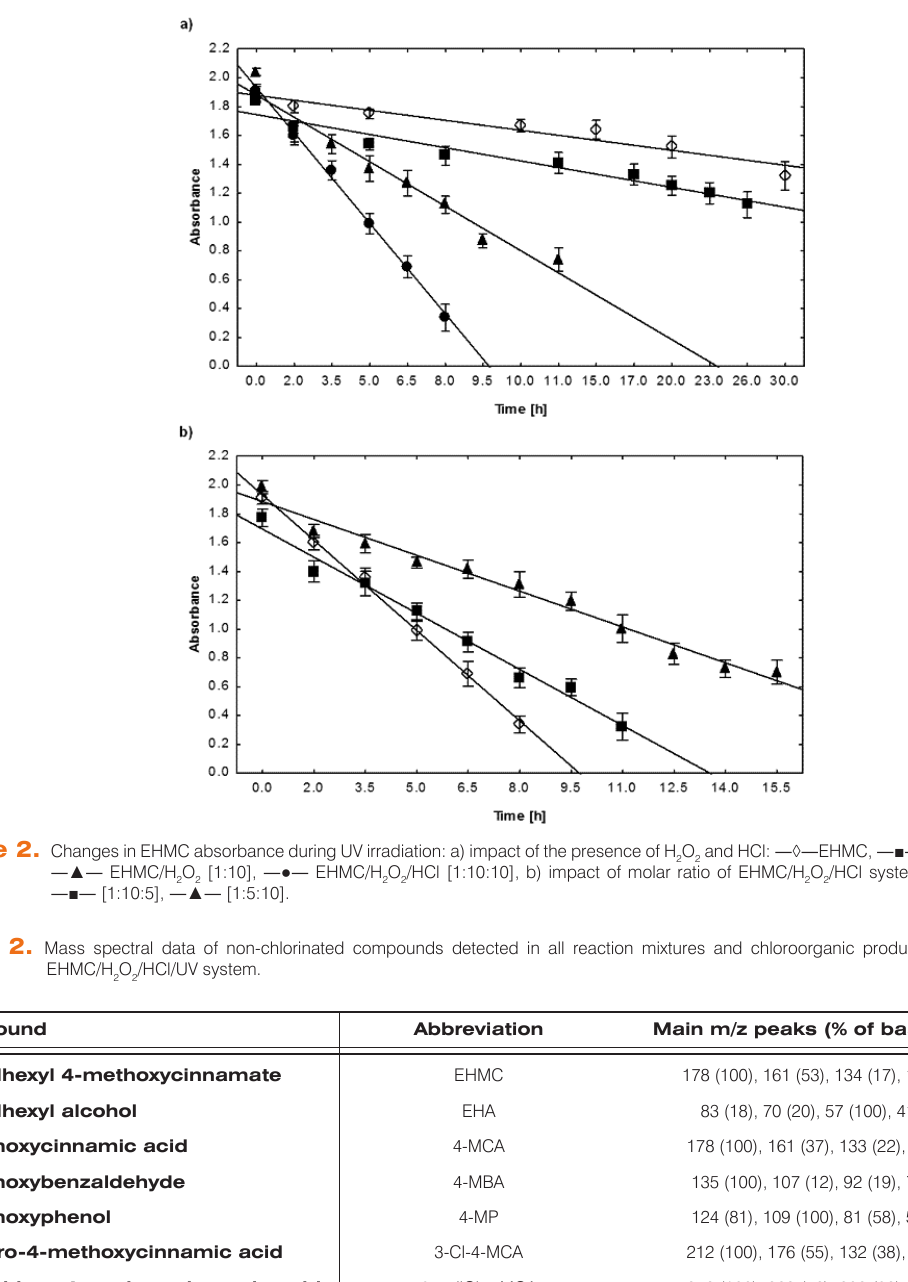
O and HCl: ― ◊ ― EHMC, ―■― EHMC/HCl [1:10], 2 2